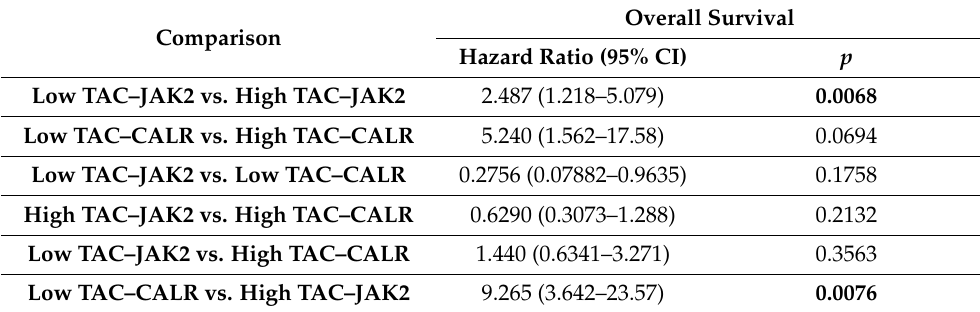
Table 1. Individual comparisons between the four curves shown in Figure 5b . Kaplan–Meier estimates of OS according to TAC plasma levels and type of mutations (Figure S2 shows individual extended data). Differences between two survival curves was evaluated by log-rank (Mantel–Cox) test. Hazard ratio was computed to determine the magnitude of difference between two curves. 95% CI, 95% confidence interval. Significant log-rank p values ( p < 0.05) are represented in bold.